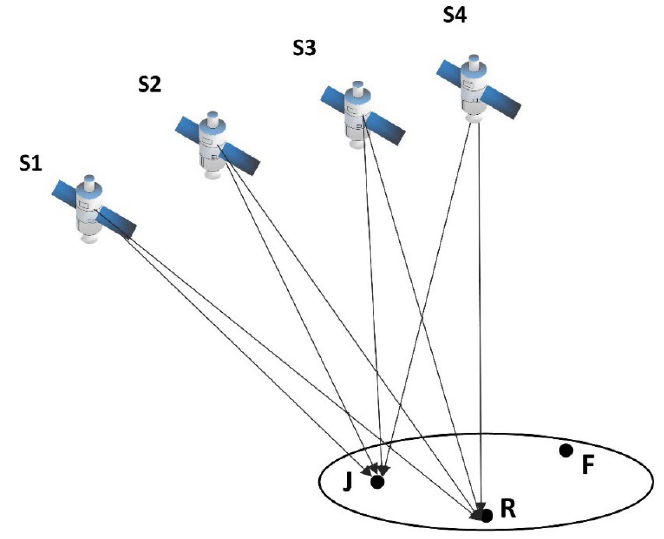
Figure 1. Transponder spoofing interference schematic.